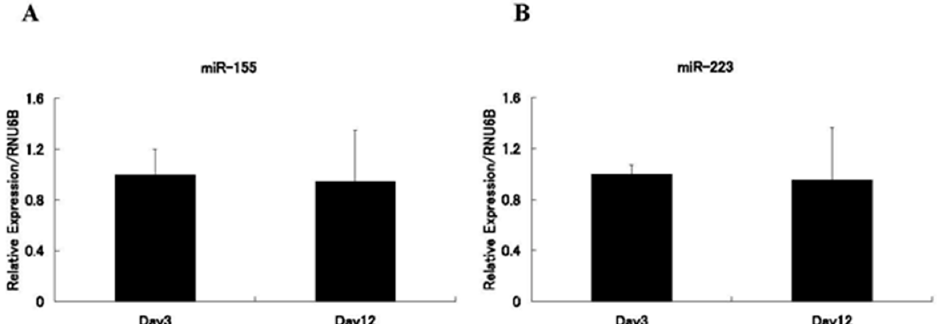
Figure 5. Expression levels of miR-155 and miR-223 during human osteoclast differentiation. Human peripheral blood CD14+ cells were treated with M-CSF (50 ng/mL) for three days, followed by RANKL (50 ng/mL) and M-CSF (25 ng/mL) for an additional nine days. Total RNAs were harvested at day 3 (macrophages) or day 12 (osteoclasts). The expression levels of miR-155 ( A ) and miR-223 ( B ) were then analyzed by quantitative RT-PCR. Values for each miRNA are expressed relative to those on day 3, which were set to 1. Quantification was performed using RNU6B as an endogenous control. The experiments were performed in triplicate. Data are presented as means ± SD. Student’s t -tests were performed to assess significant differences.